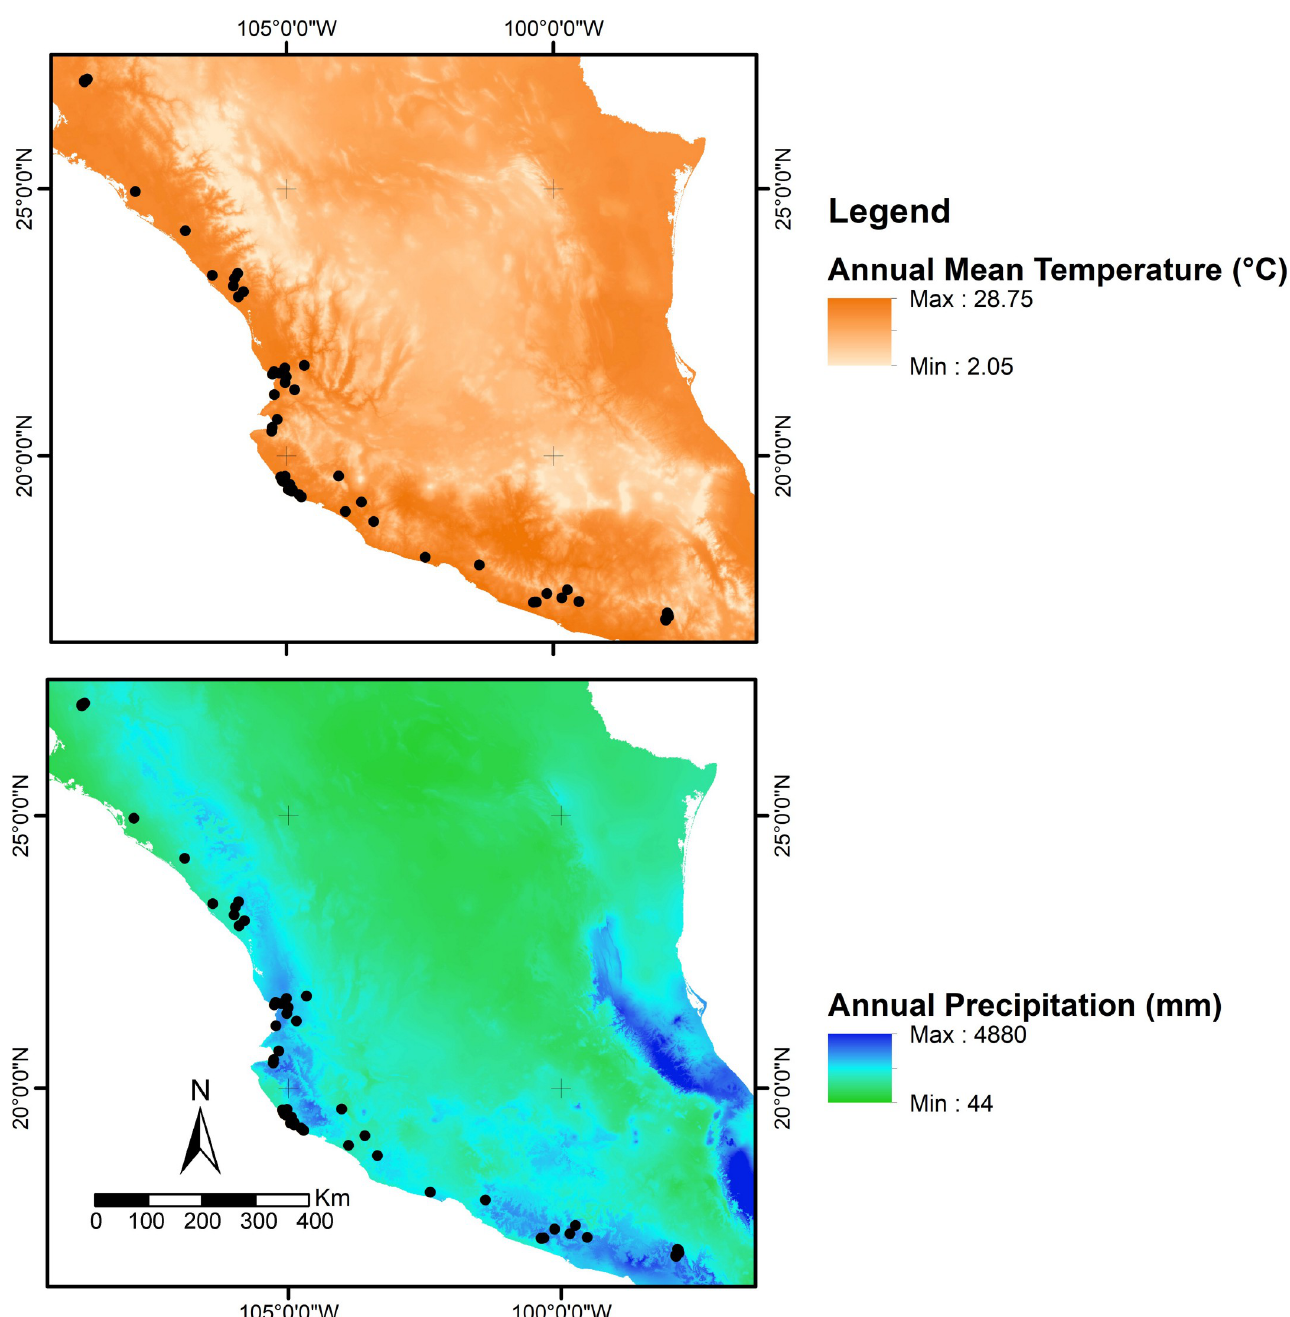
Fig 1. Environmental variation across the species distribution. BIOCLIM variables retrieved from WorldClim and projected into maps, showing (A) annual mean temperature (bio1) and (B) annual precipitation (bio12) across sampling localities of the Sinaloa Wren (black dots).